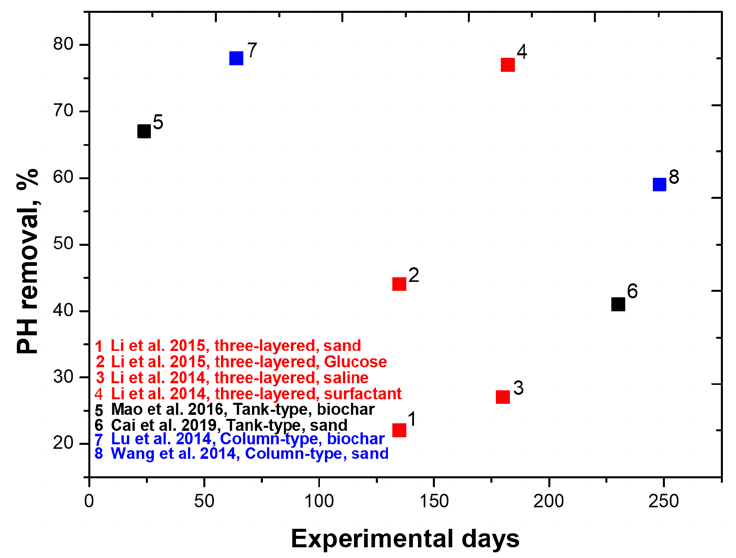
Figure 5. Effect of reactor operation days and additives on PH removal. The results are derived from [12,21,44,47,48,122].